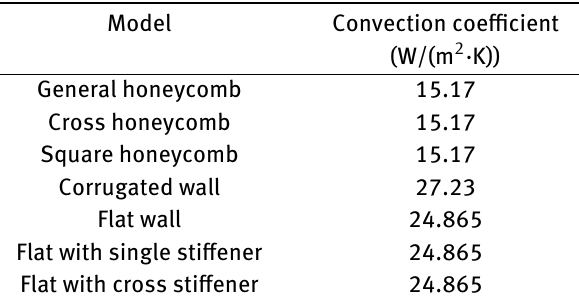
Table 2: List of the convection coeflcients of all studied models